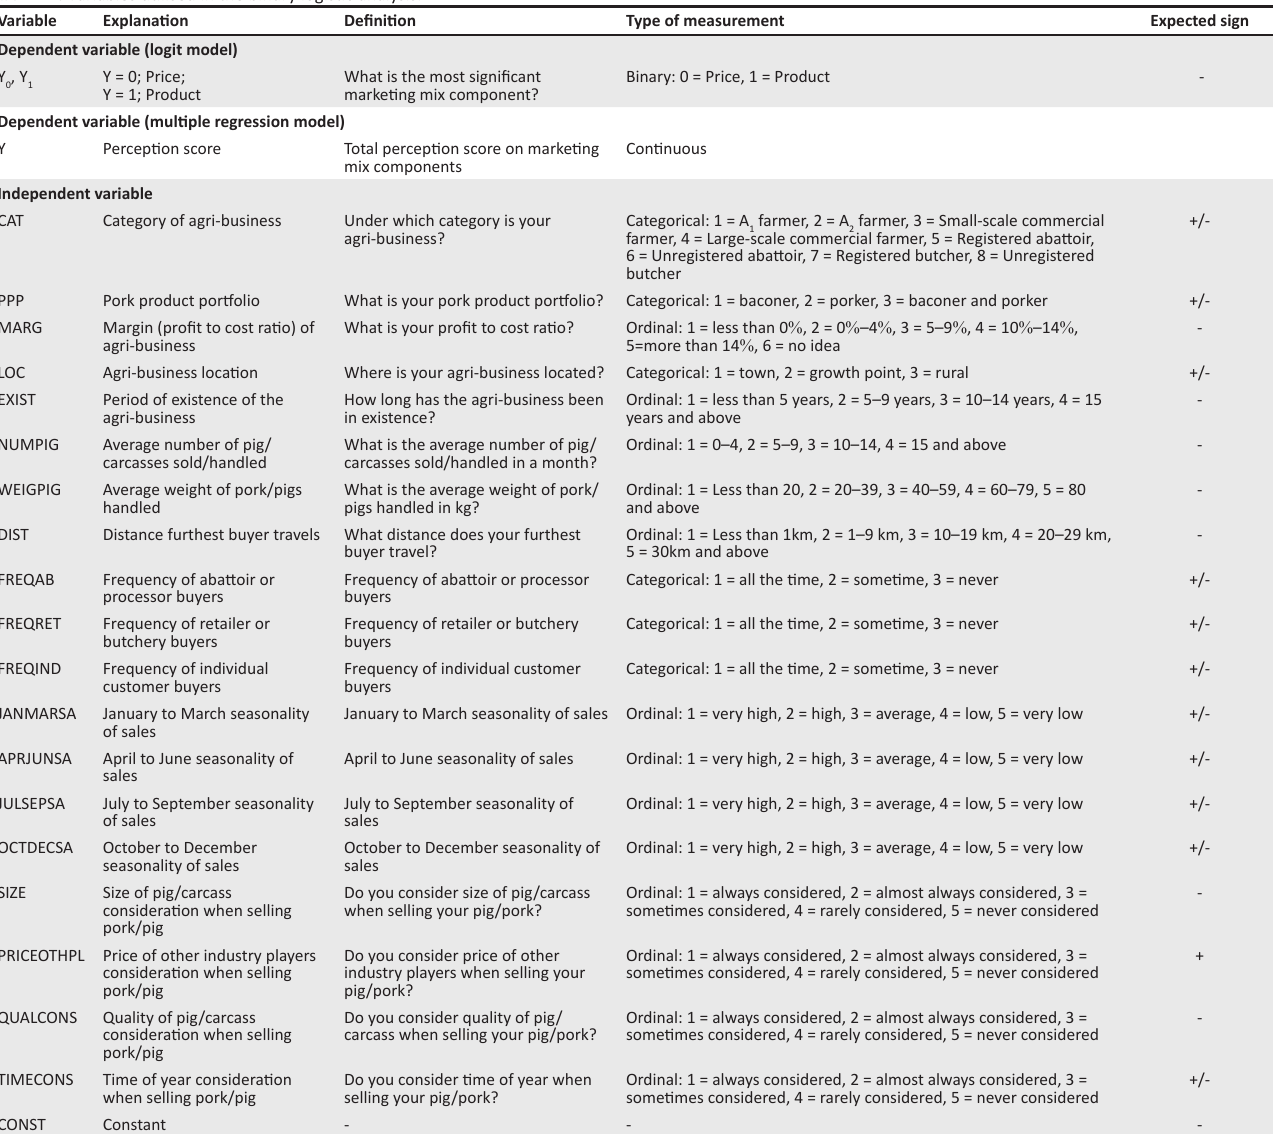
TABLE 2: Variables utilised in the binary logistic analysis. Variable Explanation Definition Type of measurement Expected